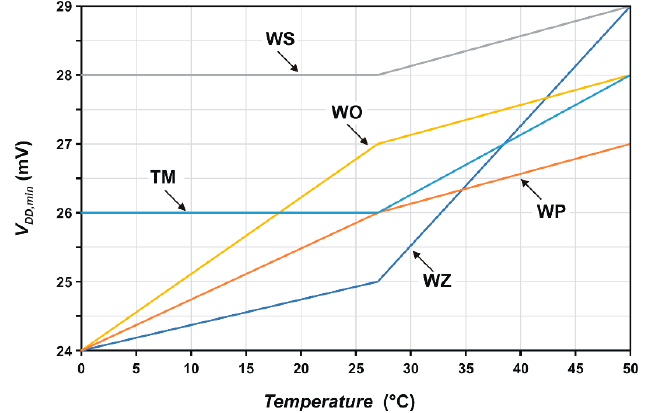
Figure 11. Minimal startup voltage, V DD,min , as a function of temperature and variations of technol- ogy parameters, represented by corners.